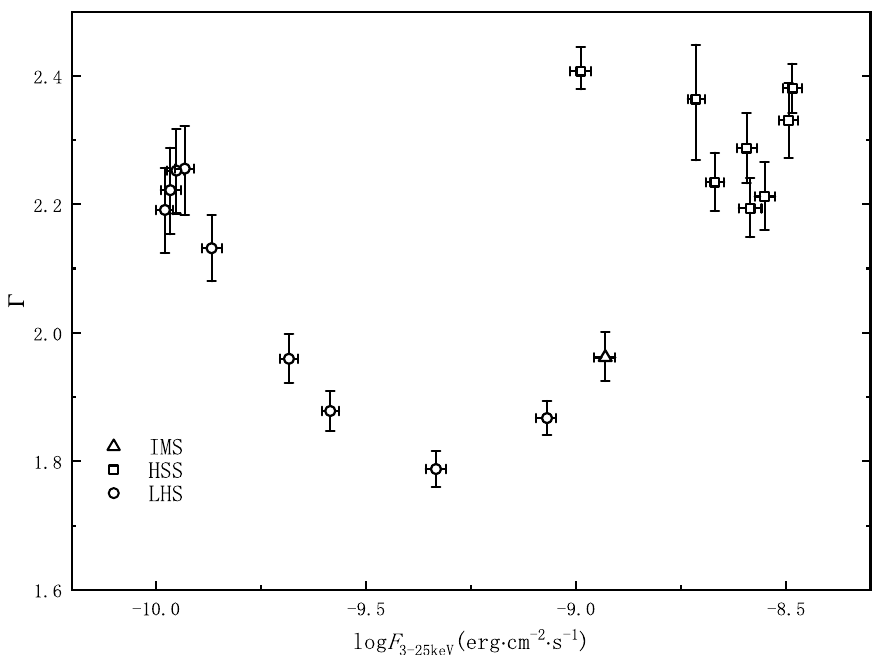
Figure 6. The correlation between the spectral index Γ and the X-ray flux, F 3 − 25keV of H 1743-322 during the 2005 outburst. The symbol types are the same as Figure 1.